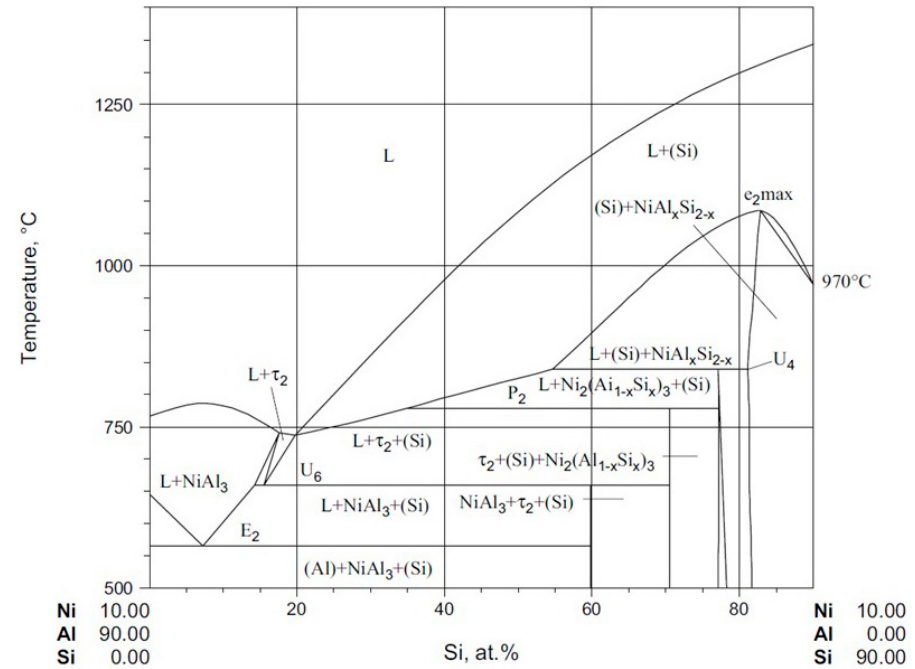
Figure 1. The position of Al 79 Si 11 Ni 10 alloy in vertical projection of ternary diagram for 10% nickel [18]. The deep eutectic, noticed for the 11% Si position, should benefit in the glass-formation capacity of the